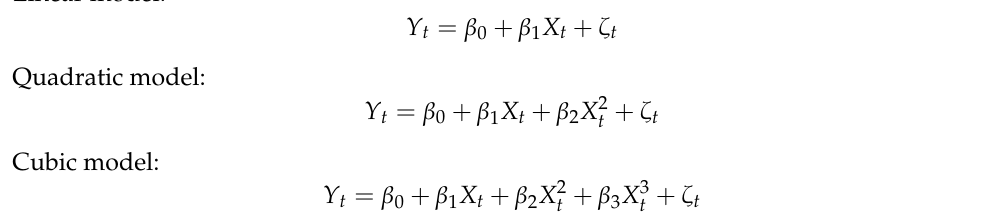
Figure 4. Indicators of water use and socio-economic development in 2003 and 2017.